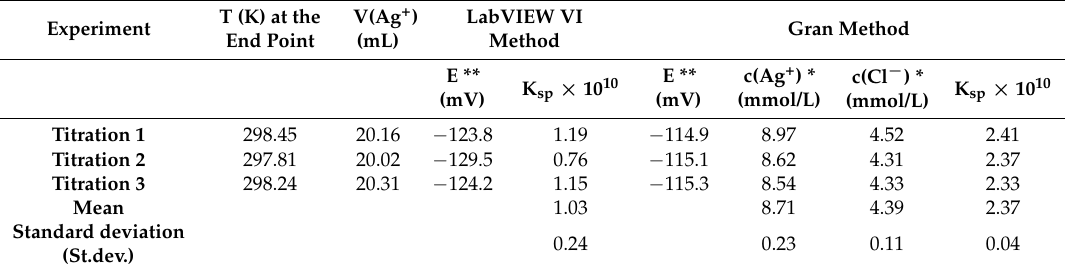
Table 1. Results at the end point of a precipitation titration of three replicates of a 40.00 ± 0.04 mL